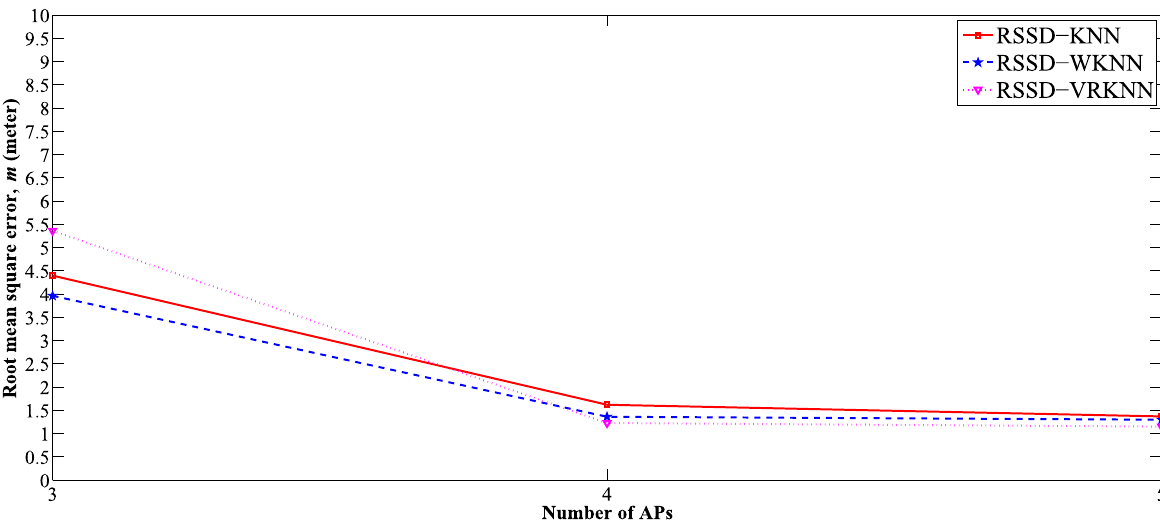
The mean location errors of RSSD-KNN, RSSD- WKNN, and RSSD-VRKNN algorithms are shown as in Table 4. The grid distance of the positioning area is 1.8 m. In order to represent the performance of the proposed algorithm, two databases with different fre- quencies and the same strength were established, which are 300 Mhz/20 dB and 1 Ghz/20 dB. The combina-